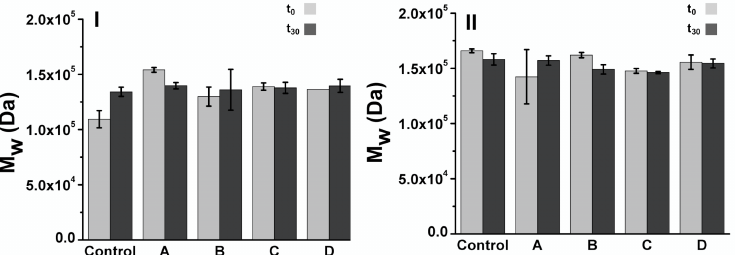
Figure 10. Molecular weight estimated by GPC for of 3D-printed/electrospun ellipsoidal ( I ) and ( II ) square composites immersed in SBF media for 30 days A control sample is a composite prepared without cover the surface of 3D-printed pieces with fibers, and A-D are those prepared with PLA based fibers: (A) PLA10, (B) PLA/PEG, (C) PLA/PEG/2.5HA, and (D)